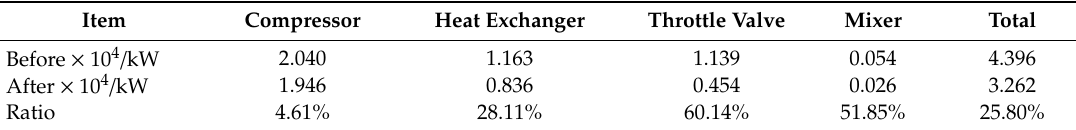
Table 6. Exergy loss of each equipment before and after.